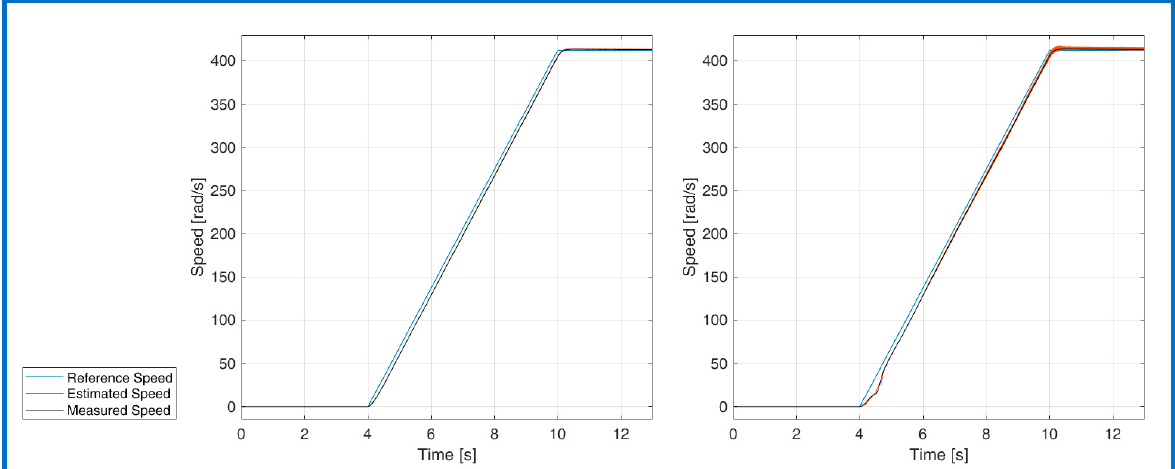
Figure 11. Reference (blue), estimated (red), and measured speed (black), with ideal generators (left) and with inverter (right).